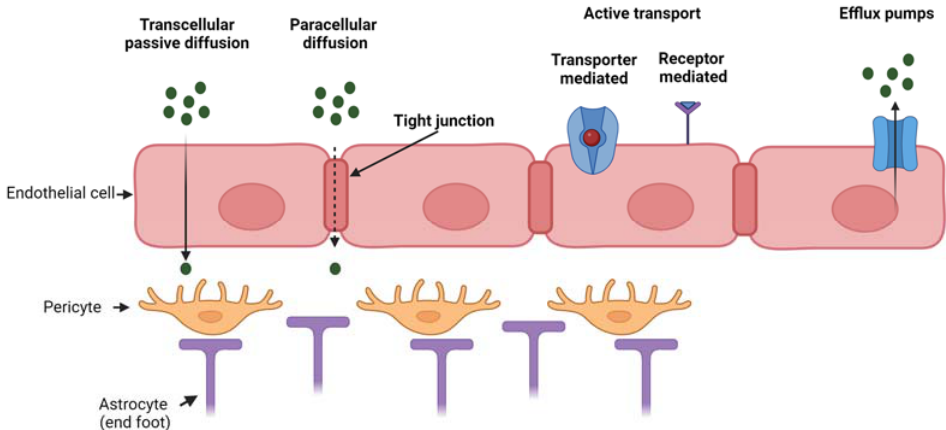
Figure 1. Mechanism of transport through the BBB which is composed of three main cell types (endothelial cells, pericytes and astrocytes). Passive transport through transcellular or paracellular diffusion, active transport (either transporter- or receptor-mediated) and efflux active pumps. Created with BioRender.com.